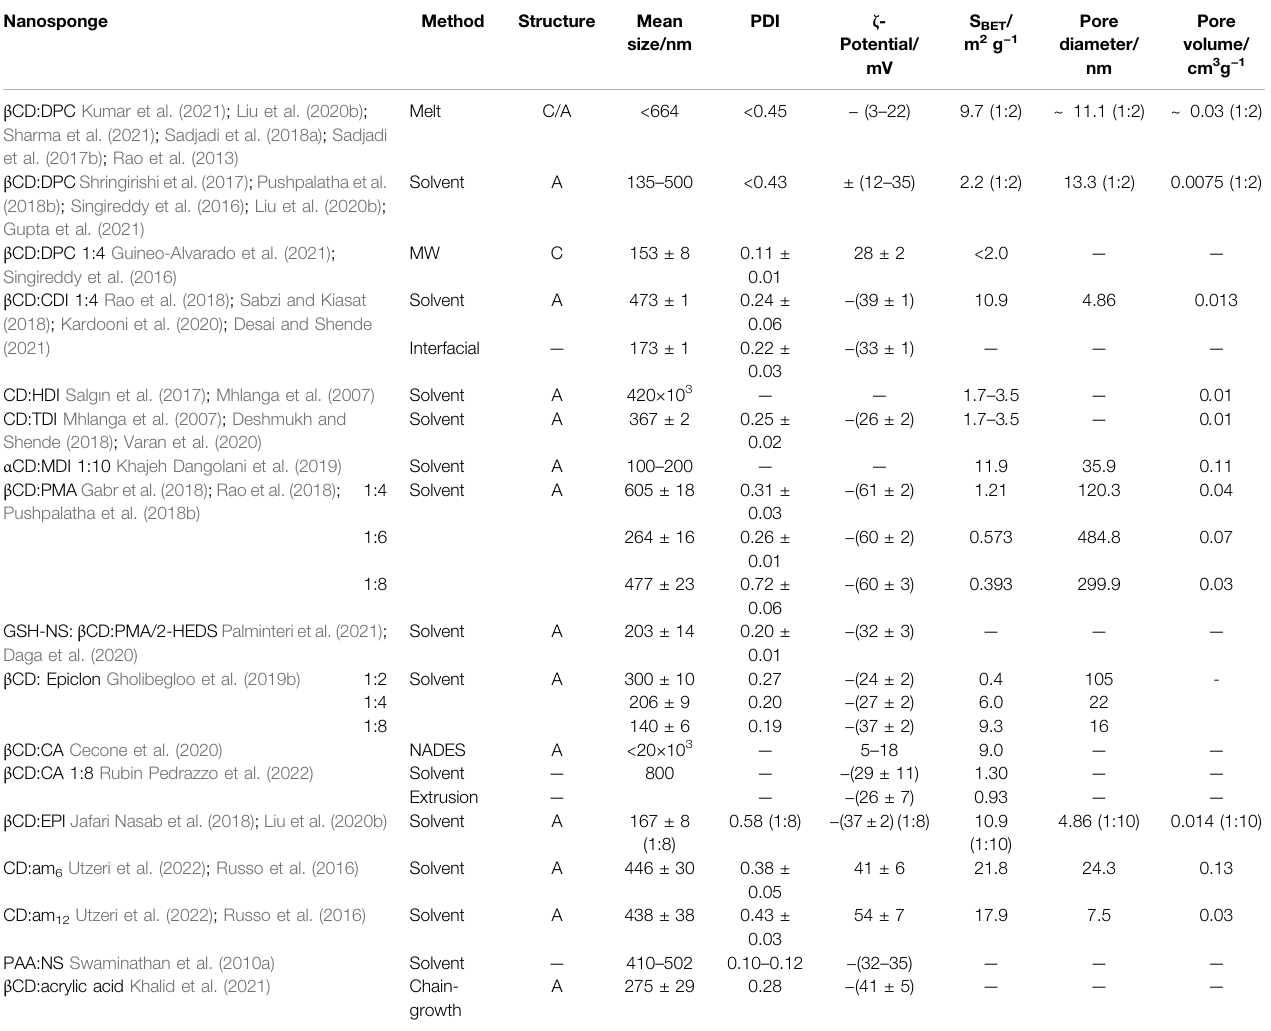
TABLE 2 | Comparative properties of different types of CDNSs. Nanosponge Method